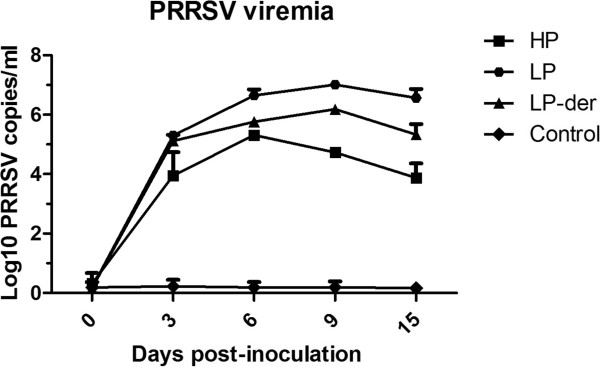
PRRSV viremia in pigs at 0 to 15 days post-inoculation with HP, LP, and LP-der PRRSV strains and DMEM medium (Control). Each data point represents the mean ± SD of the Log10 PRRSV cDNA copies/mL, as determined by quantitative PCR from the peripheral blood samples of 6 pigs in each group.